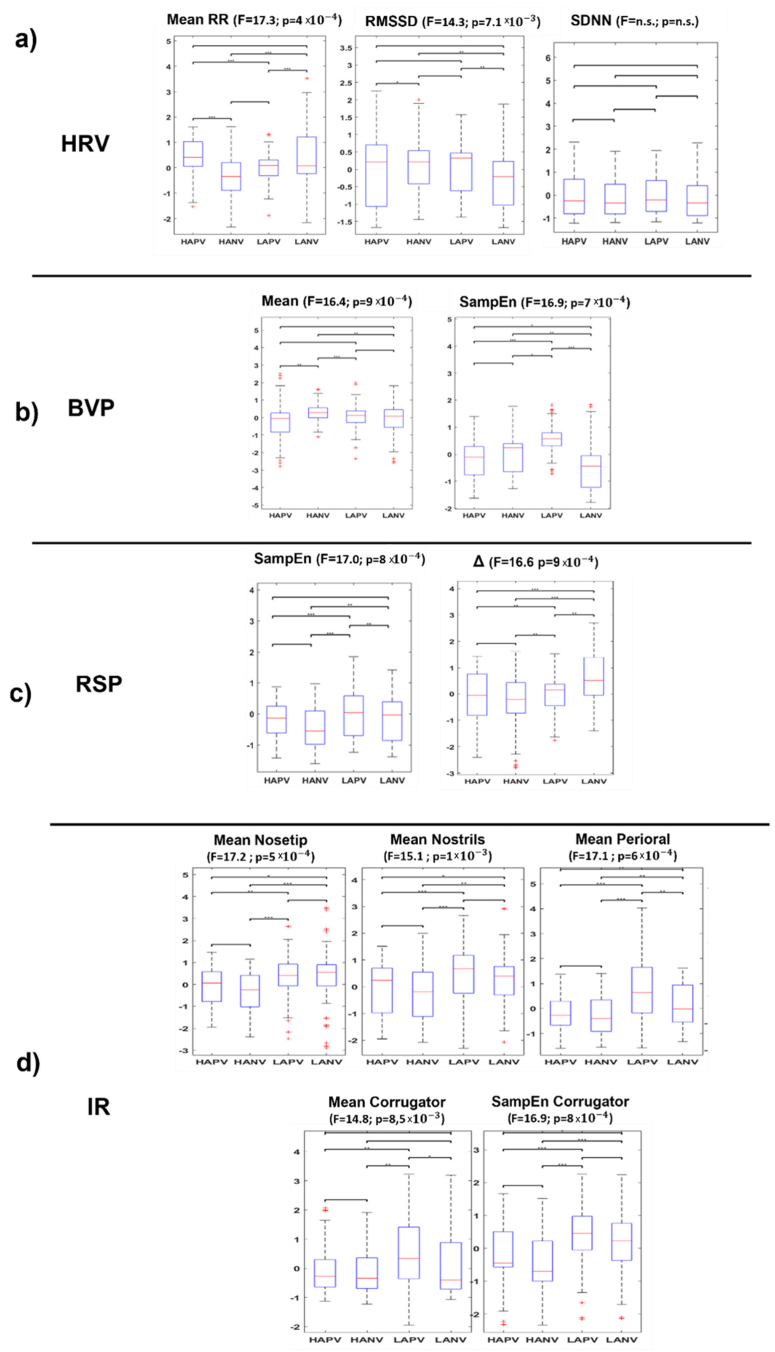
Figure 8. Feature distribution among the four classification classes (i.e., high arousal positive va- lence, high arousal negative valence, low arousal positive valence, low arousal negative valence): ( a ) Features related to the Heart Rate Variability signal: mean RR interval, the root-mean-square of successive RR interval differences (RMSSD), and the standard deviation of normal-to-normal interval (SDNN), ( b ) Features related to the Blood Volume Pulse signal: mean and Sample entropy. ( c ) Features related to the Respiratory signal: Sample Entropy and signal variation ( ∆ ), and ( d ) Features related to the Infrared signals: mean value of the nose tip, perioral and corrugator area, and sample entropy of the corrugator region. The boxes within each feature plot show the median and interquartile range, with the dashed line indicating the range of values. The title of each feature’s plot reports the repeated measure ANOVA outcome, whilst the results of the multiple comparisons are denoted by asterisks. * p < 0.05 ** p < 0.01; *** p < 0.001 for pairwise comparisons between the classification